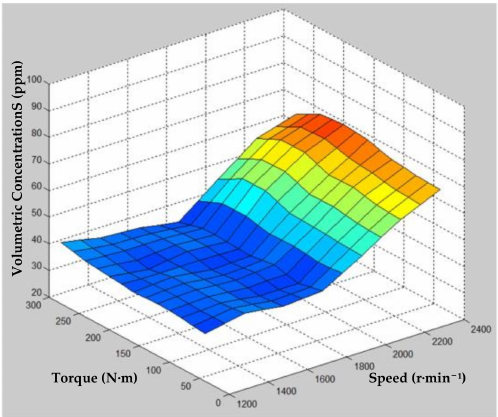
Figure 5. Three dimensional map of the HC volume concentration.